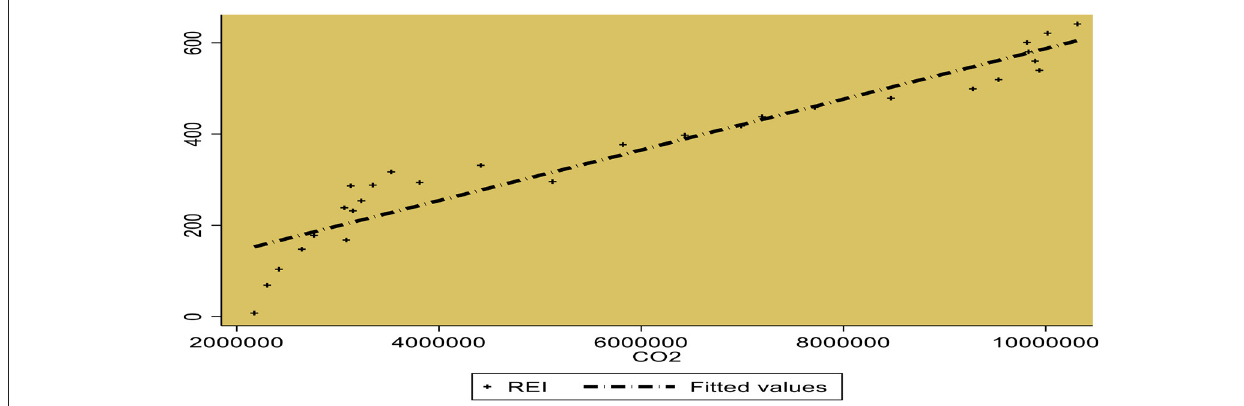
FIGURE 1 | Scatterplots of renewable energy investment vs. CO 2 emissions.